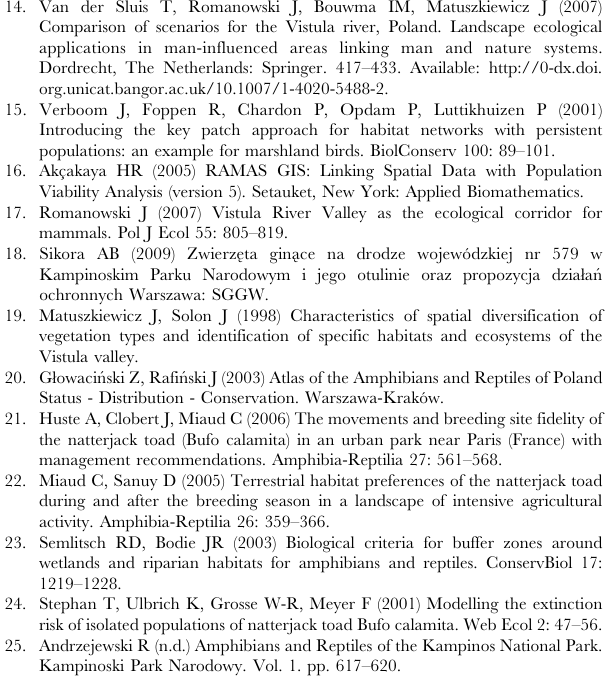
Figure S1 Results from sensitivity analysis of road mortality. Final adults’ abundances and standard deviations